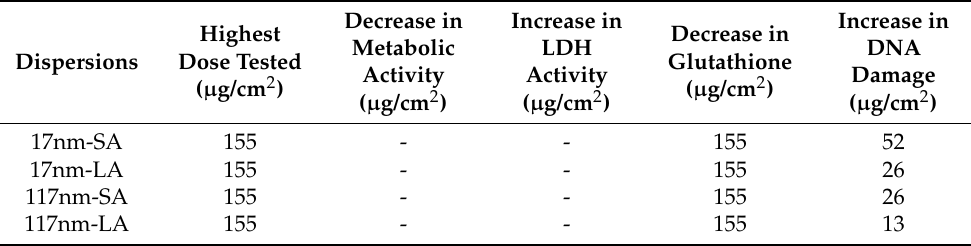
Table 4. Significant lowest observed adverse effect concentration of different TiO 2 agglomerates observed for different biological endpoints at the submerged exposure system (from our previously published study). “-” indicates no significant effect could be